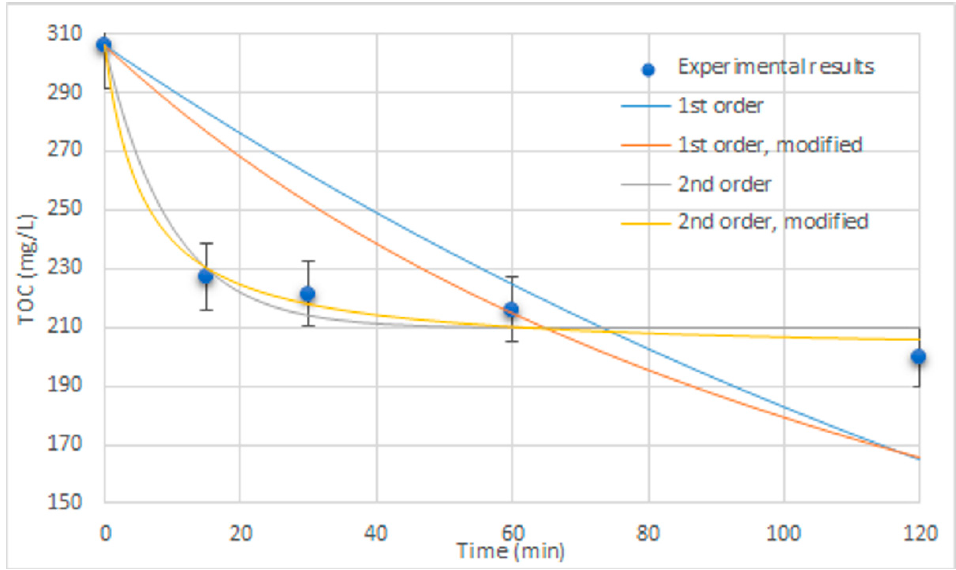
Figure 1. Example kinetic model results: 1500/1500/1000 Fe 3 O 4 /Fe 2 O 3 /Fe 0 doses (mg/L) H 2 O 2 /COD mass ratio 1:1, UV irradiation, pH = 3.0.